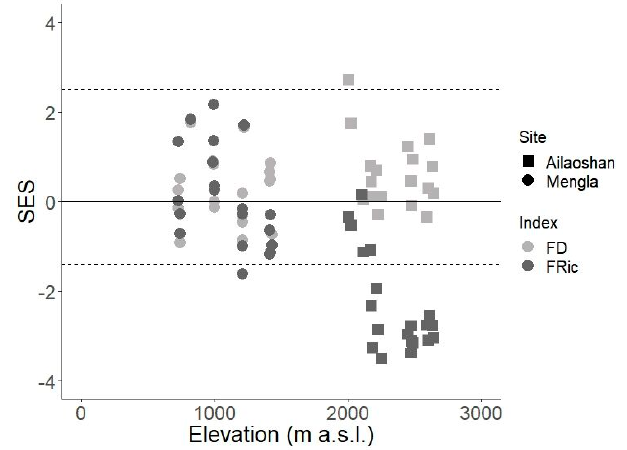
Figure 3. Standardized effect sizes (SES) for FD (light grey) and FRic (dark grey) in Mengla (circle) and Ailaoshan (square) against elevation (in m a.s.l.). Points above (for positive values) and below (for negative values) the dashed lines have SES values significantly different from the null